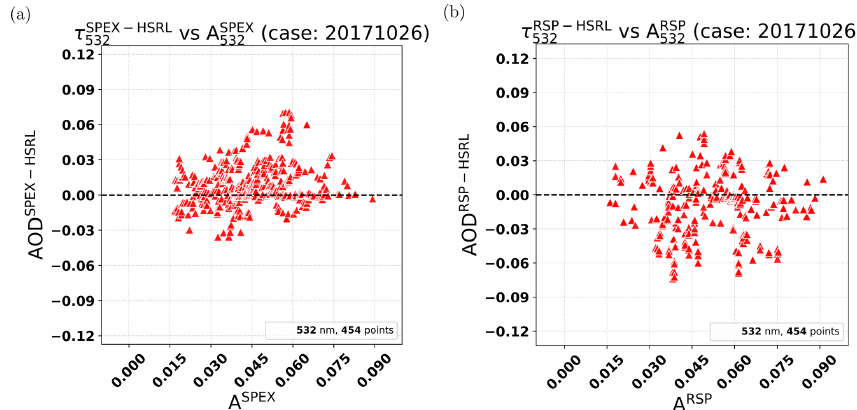
Figure 6. The AOD difference between MAP and HSRL-2 as a function of the retrieved BRDF scaling parameter A at 532nm. (a) AOD difference between SPEX and HSRL-2 versus A . (b) AOD difference between RSP and HSRL-2 versus A